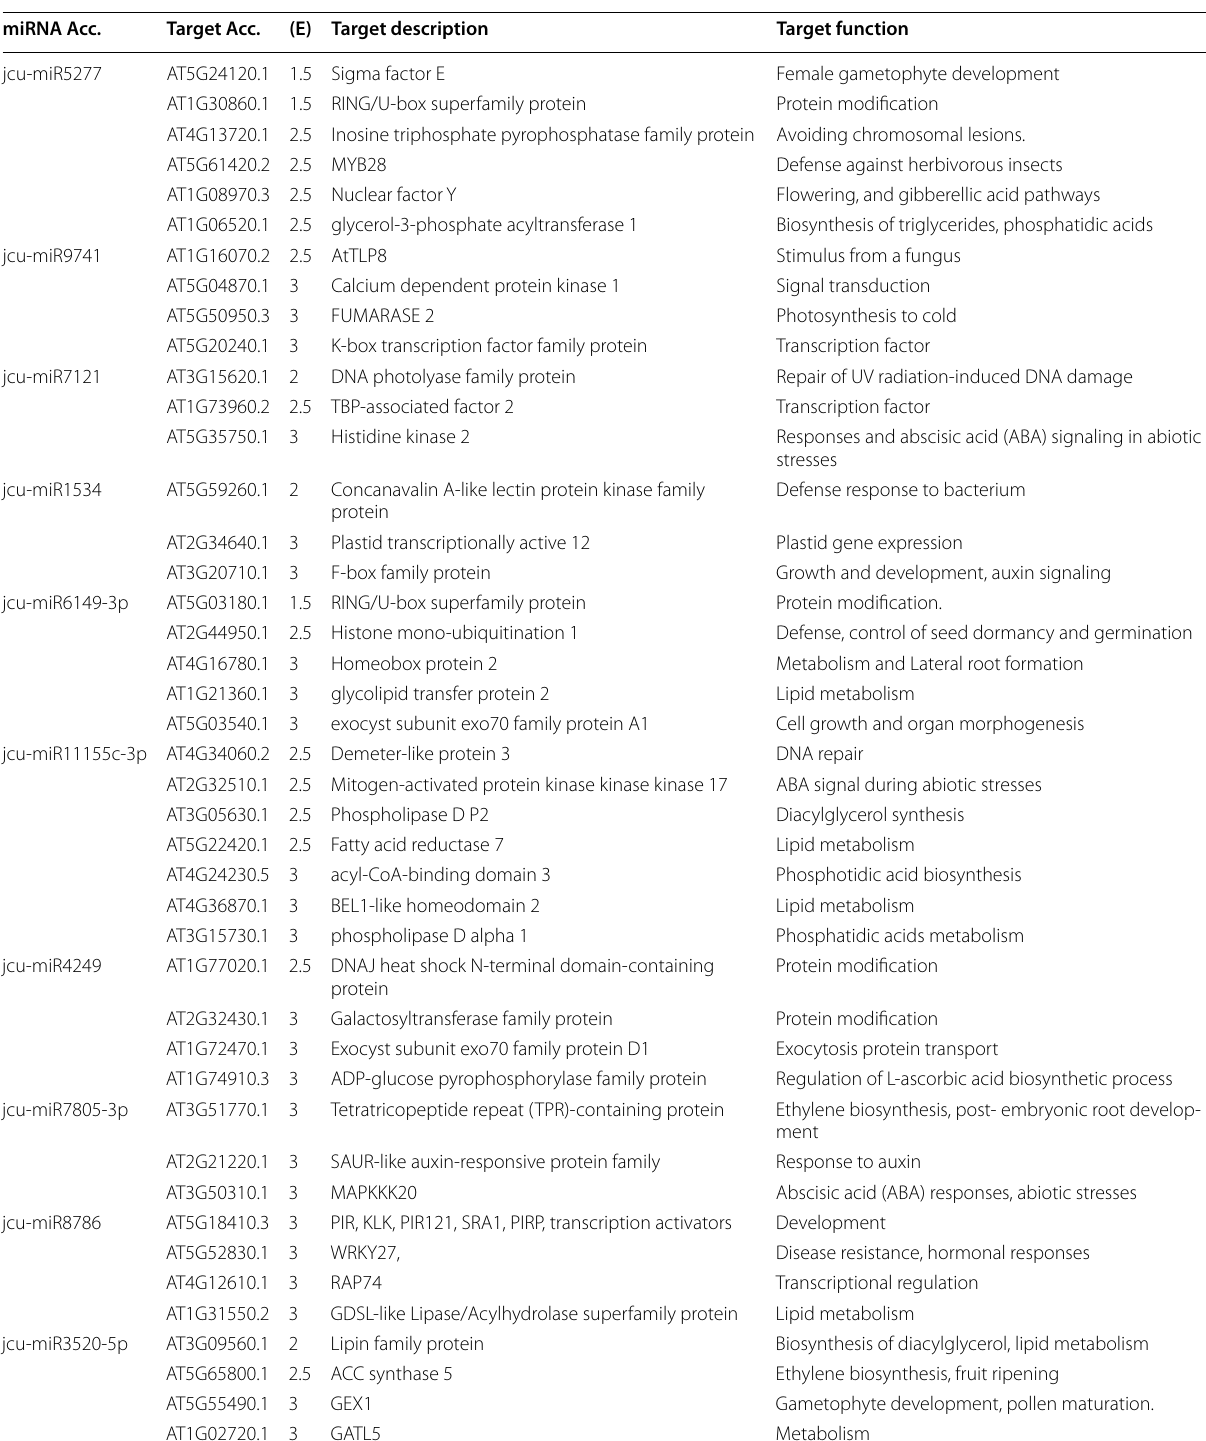
Table 2 The selected gene targets of newly identified miRNAs miRNA